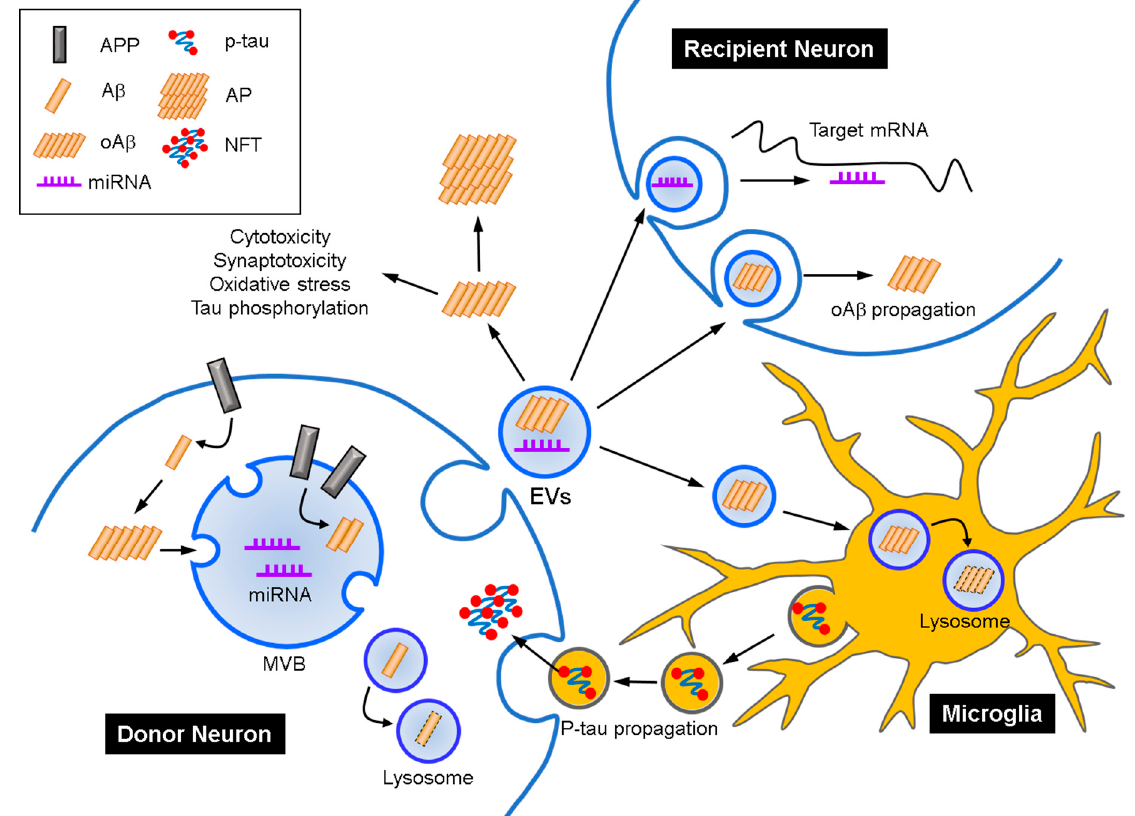
Figure 1. Potential pathological roles of extracellular vesicles (EVs) in Alzheimer’s disease (AD). Neurons release EVs containing A β monomers and oligomers (oA β ) and miRNAs. Microglia take in A β -associated EVs, then degrade A β using the lysosomal system. Exosome-associated A β can produce neurotoxic amyloid plaques (AP) outside the cells, when microglia-mediated clearance does not work properly. On the other hand, the EVs enter adjacent neurons by clathrin-mediated endocytosis or pinocytosis. Then, miRNAs promote the A β -generating pathway by targeting the mRNAs which are involved in amyloid precursor protein (APP) processing directly or indirectly. Conversely, hyperphosphorylated tau (p-tau) is transferred from microglia to neurons through EVs. Altogether, EVs may act as a main pathway in the propagation of protein aggregates between cells in the central nervous system. MVB, multivesicular body; NFT, neurofibrillary tangle.